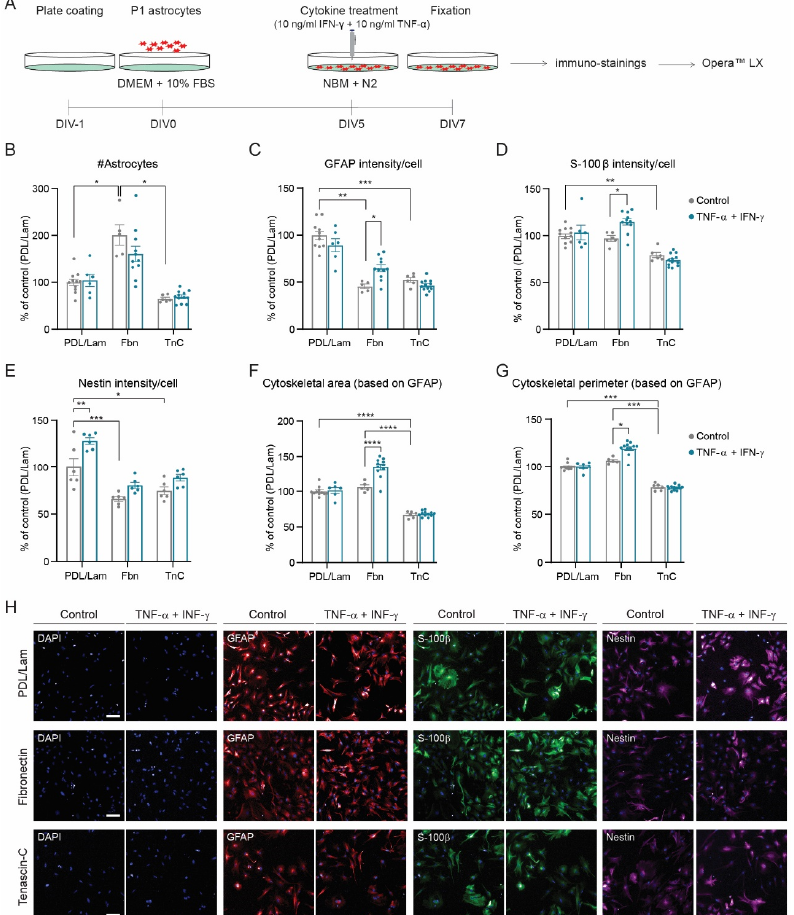
Figure 2. Cytokine-induced reactive astrogliosis in vitro: the effect of plate coating. ( A ) Experimental design. Analysis of ( B ) number of astrocytes, ( C ) GFAP intensity per cell, ( D ) S-100 β intensity per cell, ( E ) Nestin intensity per cell, ( F ) cytoskeletal area (based on GFAP intensity), and ( G ) cytoskeletal perimeter (based on GFAP intensity). ( H ) Representative images of DAPI (blue), GFAP (red), S- 100 β (green), and Nestin (magenta) for each condition. PDL/Lam (PDL/Laminin), Fbn (fibronectin), and Tnc (tenascin-c). Data were normalized to PDL/Lam unstimulated. N = 6–10 wells/condition; n = 7804 and n = 4438 astrocytes analyzed for PDL/Lam-unstimulated and PDL/Lam-stimulated con- dition, respectively; n = 7055 and n = 12533 for Fbn condition; and n = 2790 and n = 5967 for TnC condition. Data are presented as the mean ± SEM. Two-way ANOVA with a Bonferroni post hoc test: * p < 0.05, ** p < 0.01, *** p < 0.001, and **** p < 0.0001. Scale bar: 100 μ m.